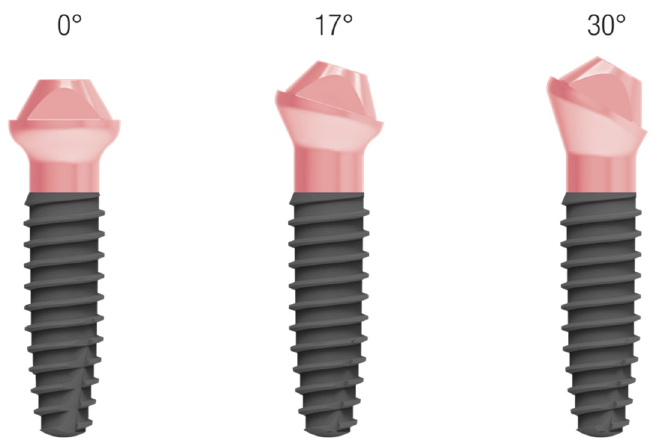
Figure 3. The FIXO system with integrated MUA in its 3 inclinations, 0°–17°–30°. It can be seen that the absence of the multiunit abutment reduces the thickness of the neck.